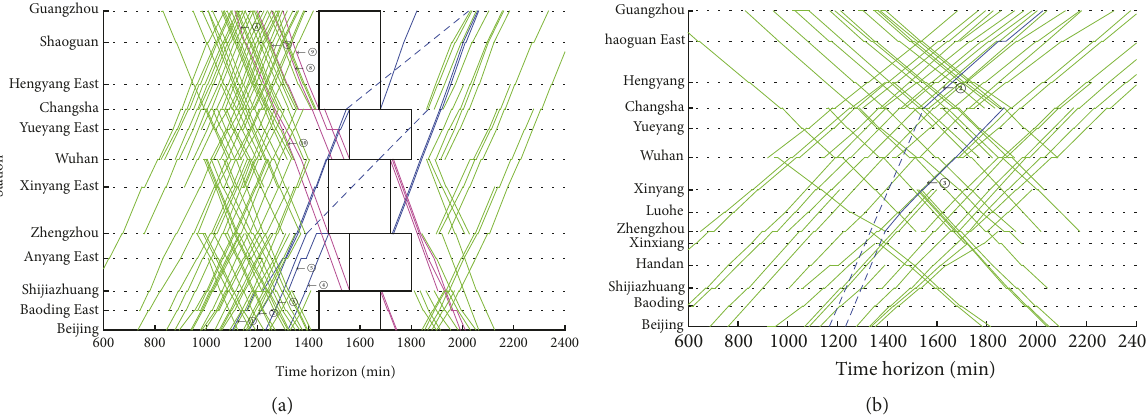
Figure 11: Time-space diagrams of SDSA-trains and existing trains on the high-speed railway (a) and the normal-speed railway